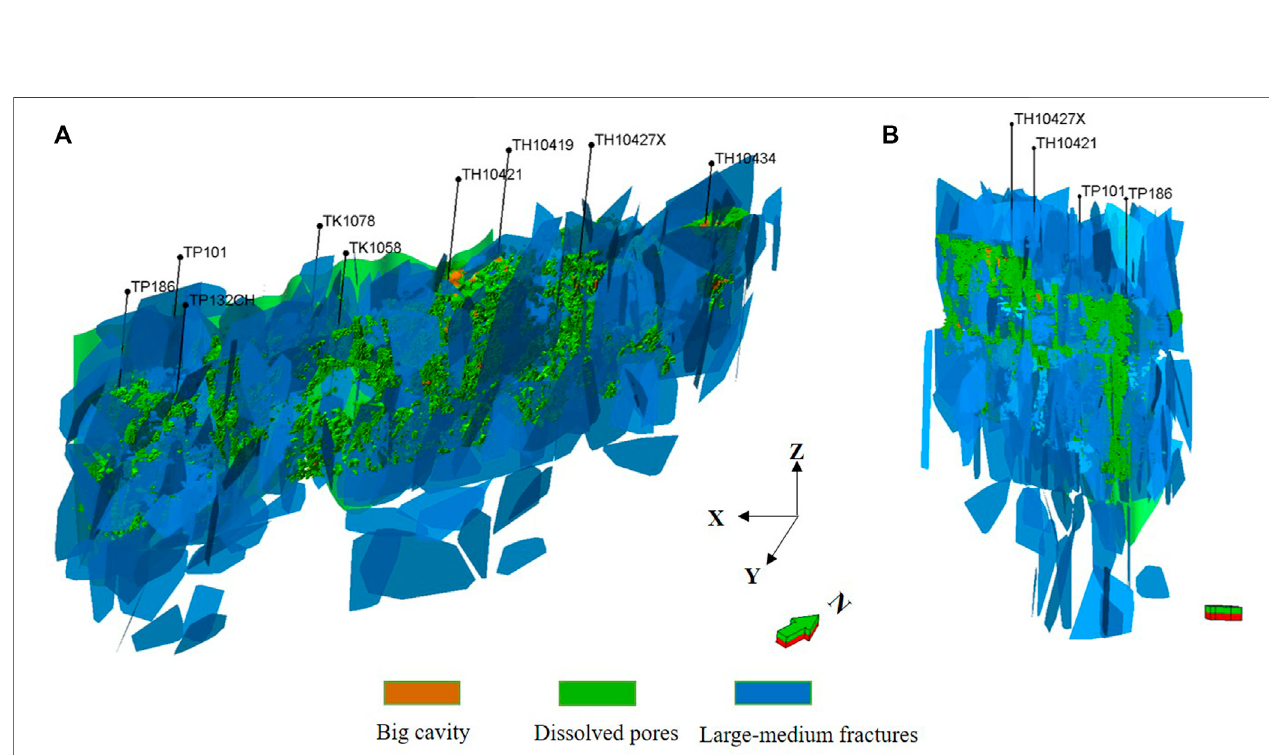
FIGURE 11 | Integrated 3D fault-controlled paleokarst geological model in the TP12CX units. (A) Three dimensional from a certain angle; (B) Three dimensional from another angle.